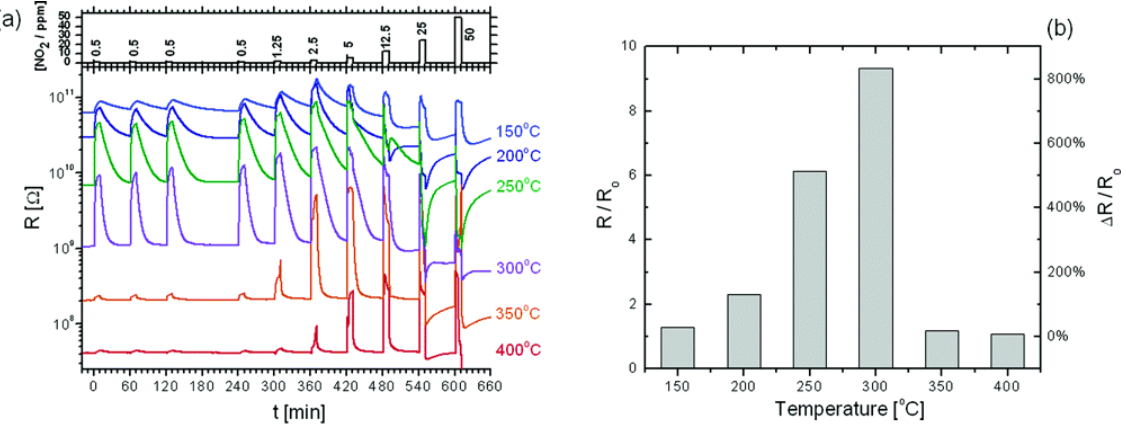
Figure 7. (a) The resistance response during cyclic exposure to 10 min pulses with mixed in dry air at various operating temperatures. (b) increasing concentrations of NO 2 Sensitivity versus temperature histogram upon exposure to 500 ppb NO designates the baseline resistance in dry air. (reproduced with permission from ref.